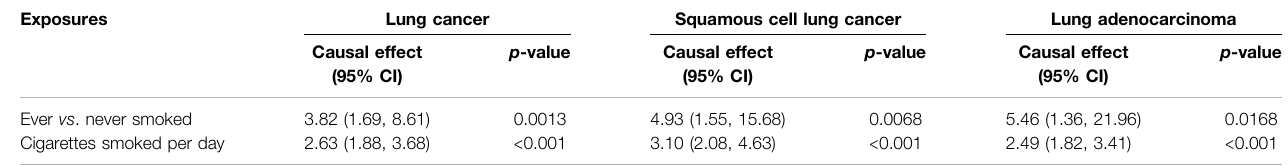
TABLE 5 | Causal effects from mediators to lung cancer and